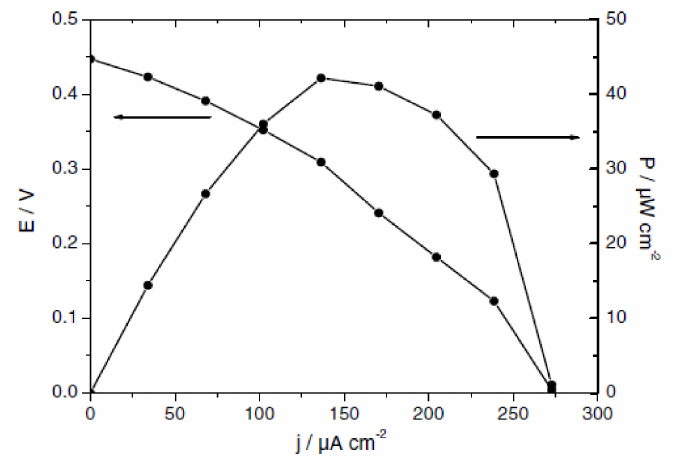
Figure 14. Experimental results obtained in [21] with the optimized enzymatic cell configuration. Reprinted from [21], with permission from Elsevier.